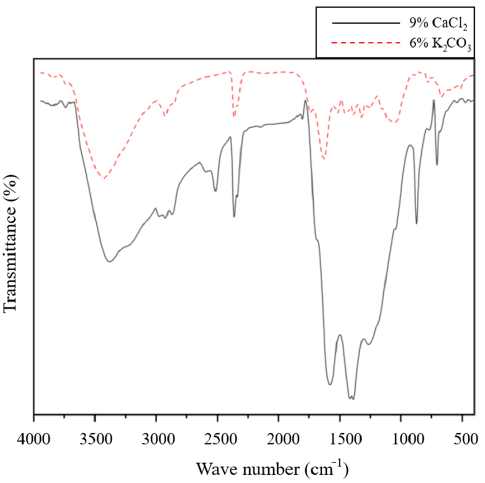
Figure 10. Fourier transform infrared absorption spectrum of activated carbon prepared by activa- tion with a 10% concentration of steam when adding 6% K 2 CO 3 and 9% CaCl